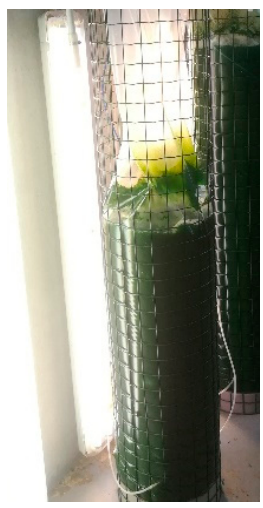
Figure 1. Vertical-column photobioreactor used for the production of microalgae.